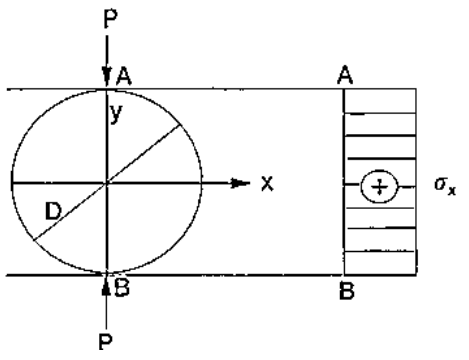
Figure 1. Schematic view of the diametral compression experiment.